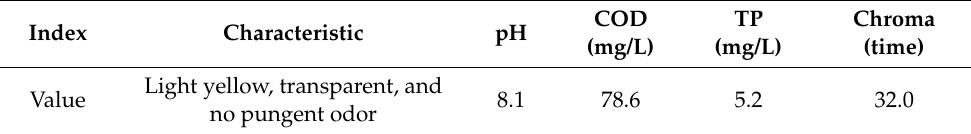
Table 1. Raw water quality of coal chemical biochemical tailwater.